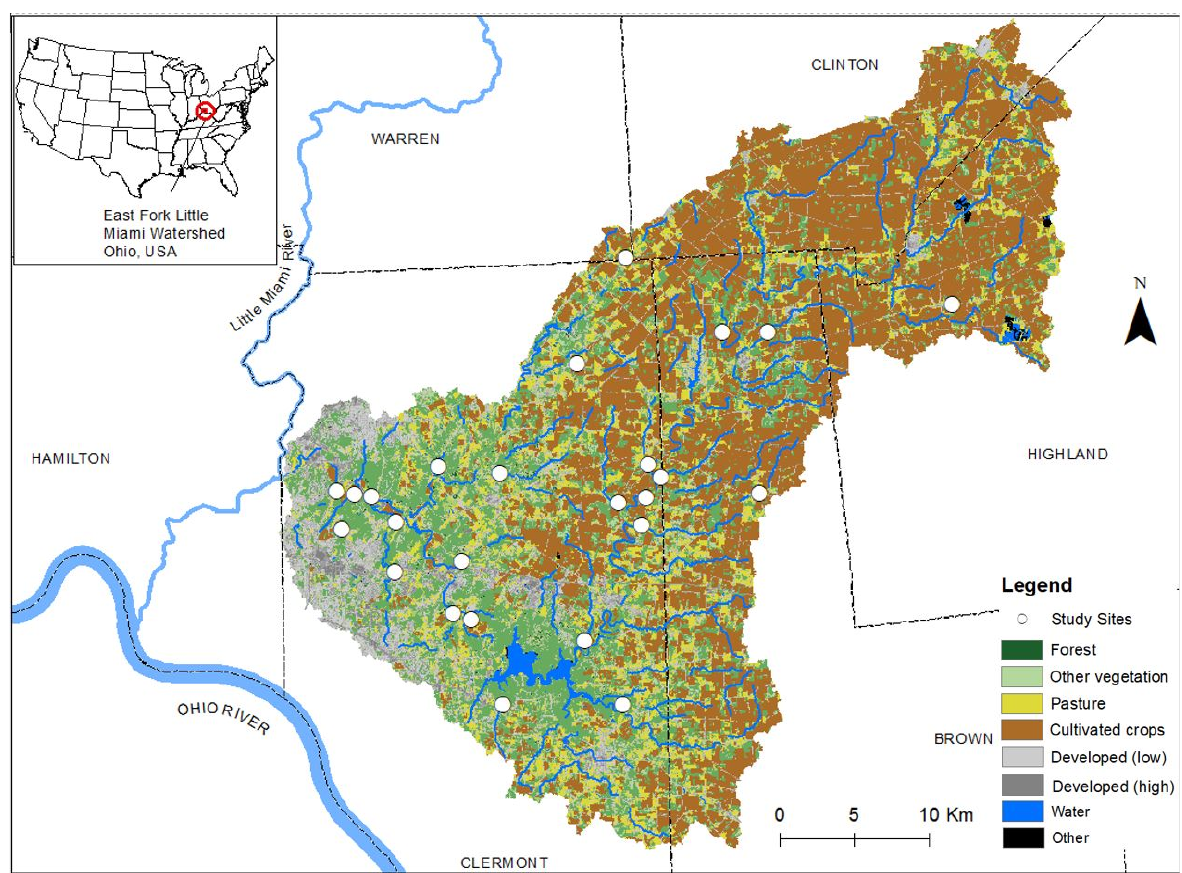
Figure 1. Map of collection sites in the East Fork of the Little Miami River Watershed.